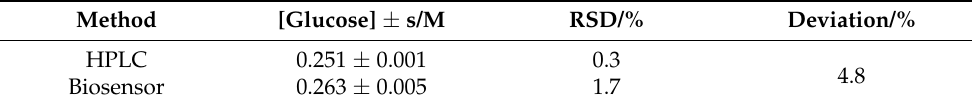
Table 3. Glucose determination using different analytical techniques on the same orange soft drink